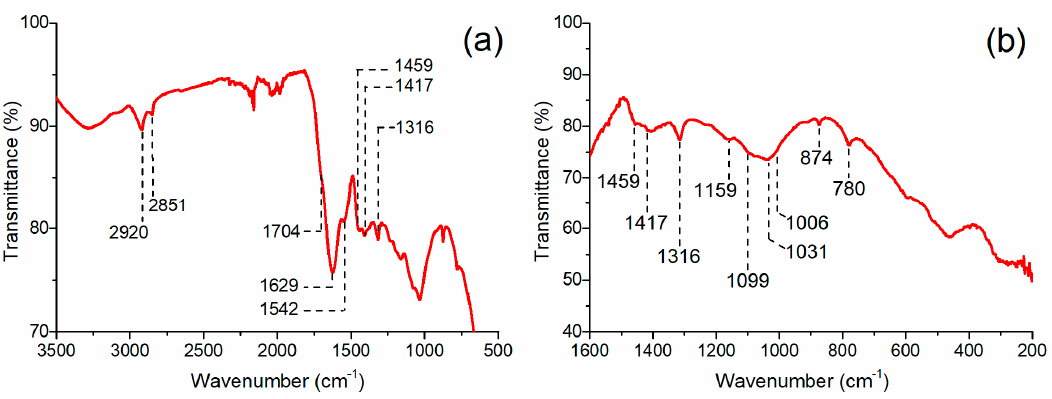
Figure 13. ATR-FTIR spectra of the red areas ranging from 3500 to 500 cm − 1 ( a ) and in the range of 1600 to 200 cm − 1 ( b ). All the spectral features are in common with the gold varnish and it was not possible to identify the nature of the pigment or coloring